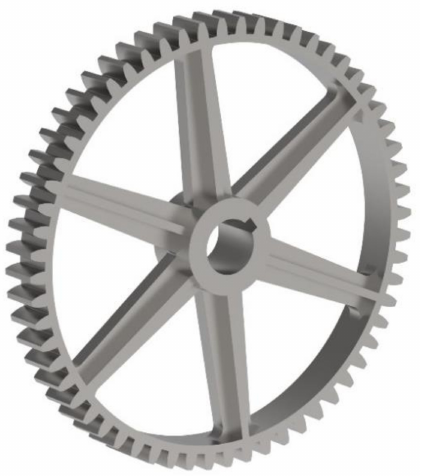
Figure 14. Driven gear with central orifice